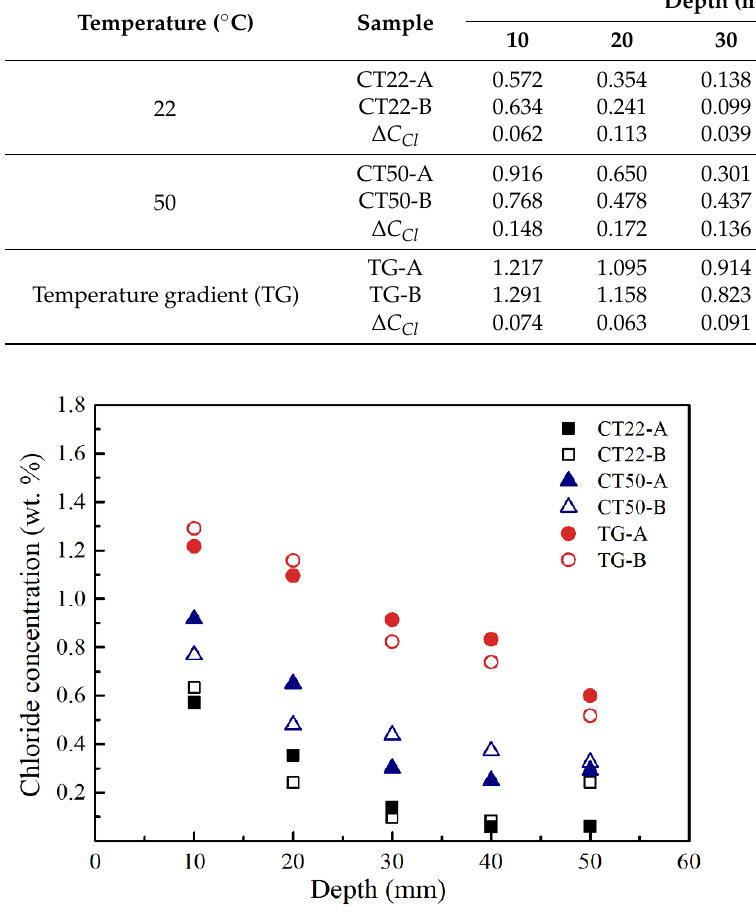
Figure 3. Chloride concentration profiles measured at depths of 10 – 50 mm after 30-day exposure to the NaCl solution. (Single-column fit).